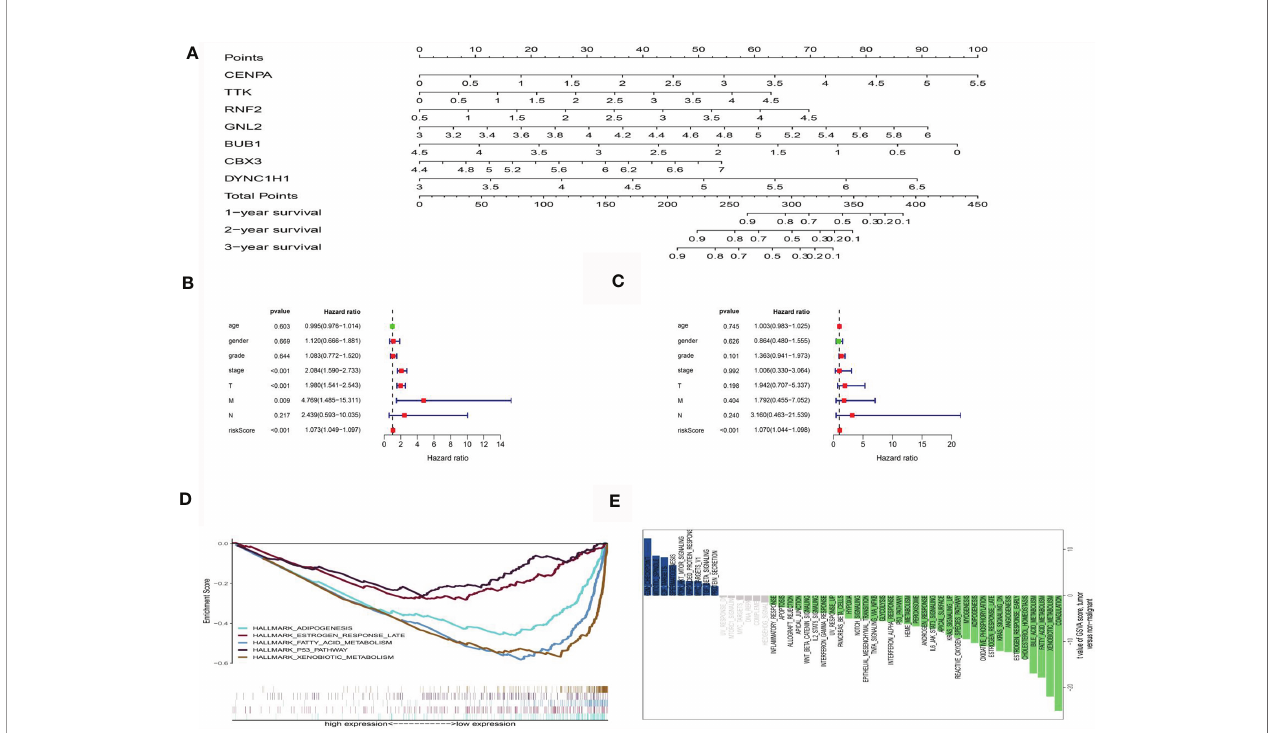
FIGURE 6 | Functional analysis between the high-PERs and low-PERs groups. (A) The nomograms for predicting the 1-, 3-, and 5-year survival rates in the TCGA data set. (B) Univariate Cox regression analysis for PERs in the TCGA data set. (C) Multivariate Cox regression analysis for PERs in the TCGA data set. (D) GSEA between the high-PERs and low-PERs groups in the TCGA data set. (E) GSVA between the high-PERs and low-PERs groups in the TCGA data